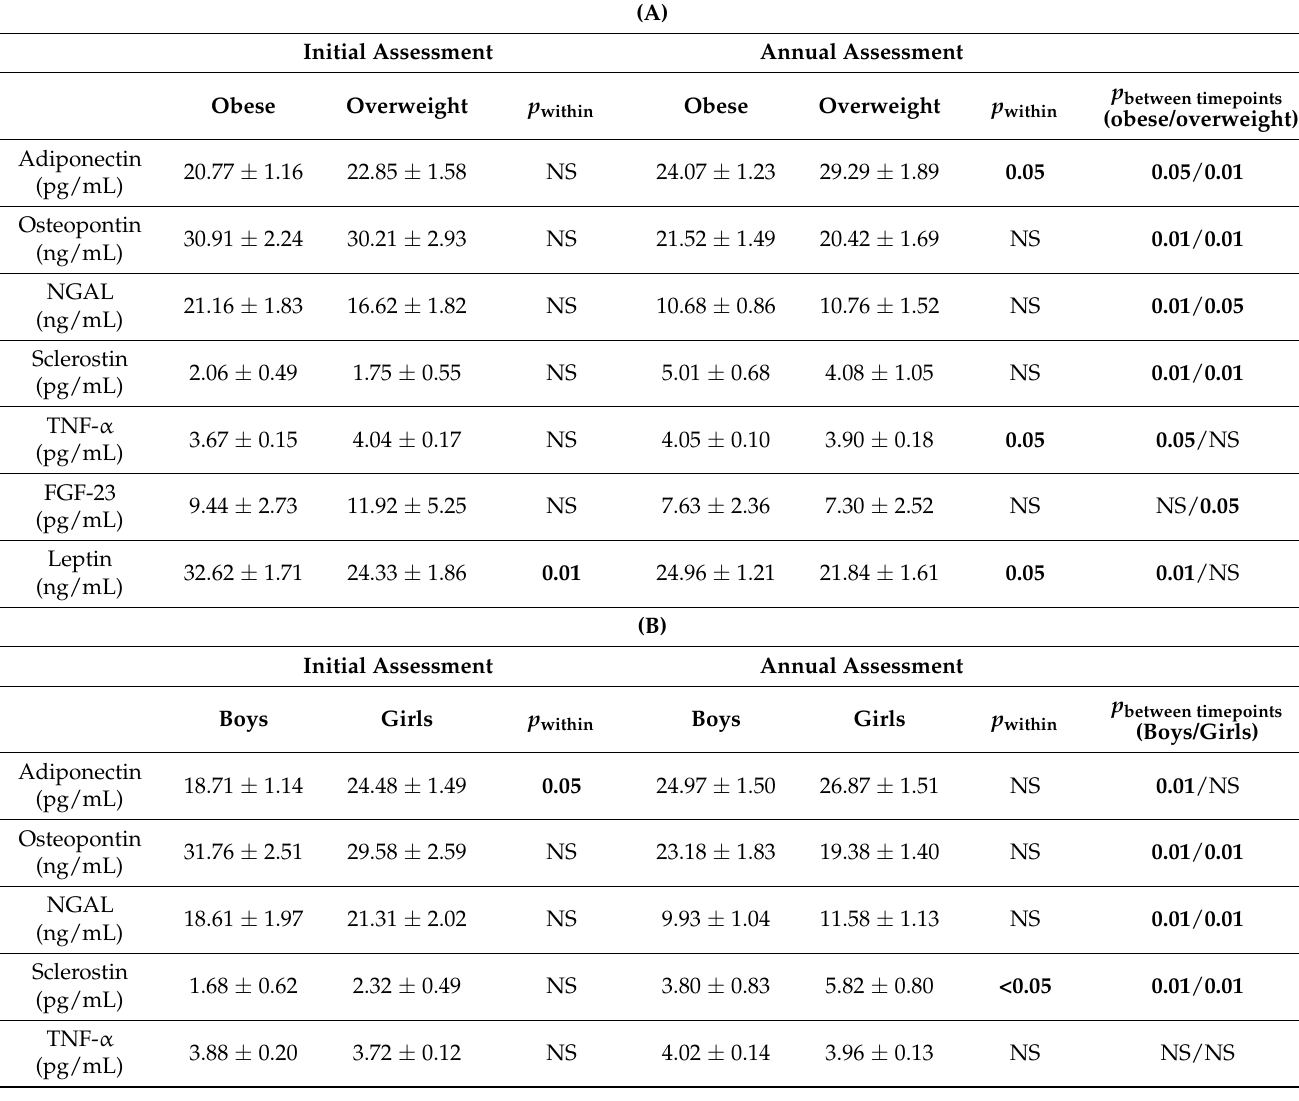
Table 4. ( A ) Bone-derived proteins and adipokines at initial and annual assessment. ( B ) Bone- derived proteins and adipokines at initial and annual assessment: Comparisons according to gender (irrespective of pubertal status). ( C ) Bone-derived proteins and adipokines at initial and annual assessment: Comparisons by gender of overweight and obese subjects, who were pre-pubertal at initial assessment. ( D ) Bone-derived proteins and adipokines at initial and annual assessment: Comparisons by gender of overweight and obese subjects, who were pubertal at initial